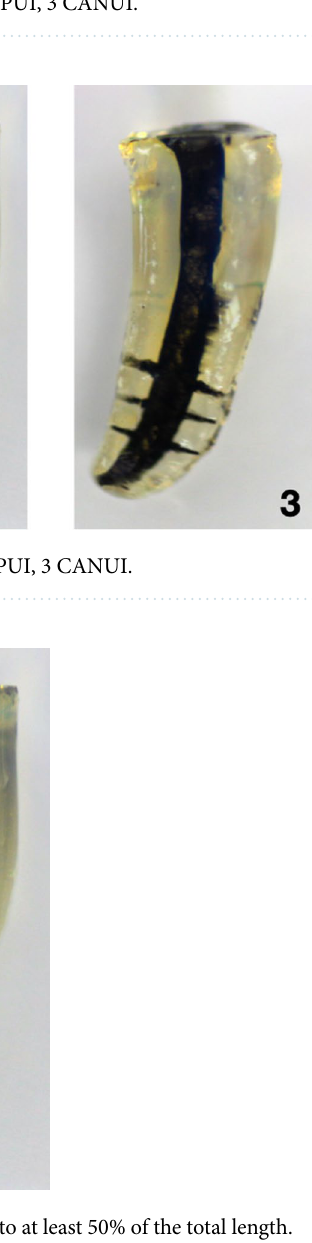
Figure 6. Representative images of straight canals. 1 PPI, 2 PUI, 3 CANUI.